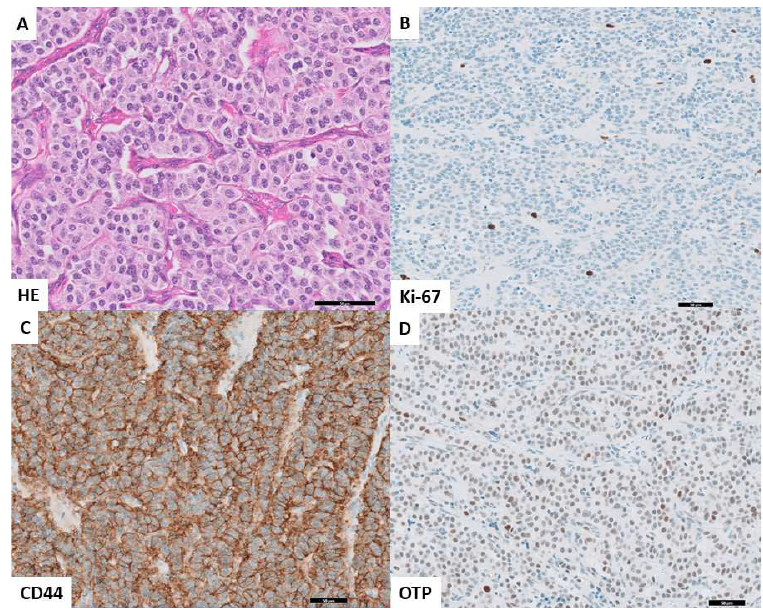
Figure 4. Prognostically favorable profile in histology and immunohistochemistry. ( A ). HE (40 × ) showing carcinoid with a well differentiated neuroendocrine morphology without mitoses. ( B ). Immunohistochemistry for Ki-67 (20 × ) showing a proliferation index of <3% in tumor cells. ( C ). Immunohistochemistry for CD44 (20 × ) with retained strong cytoplasmatic and membranous staining in the tumor cells. ( D ). Immunohistochemistry for OTP (20 × ) showing a retained nuclear staining in the tumor